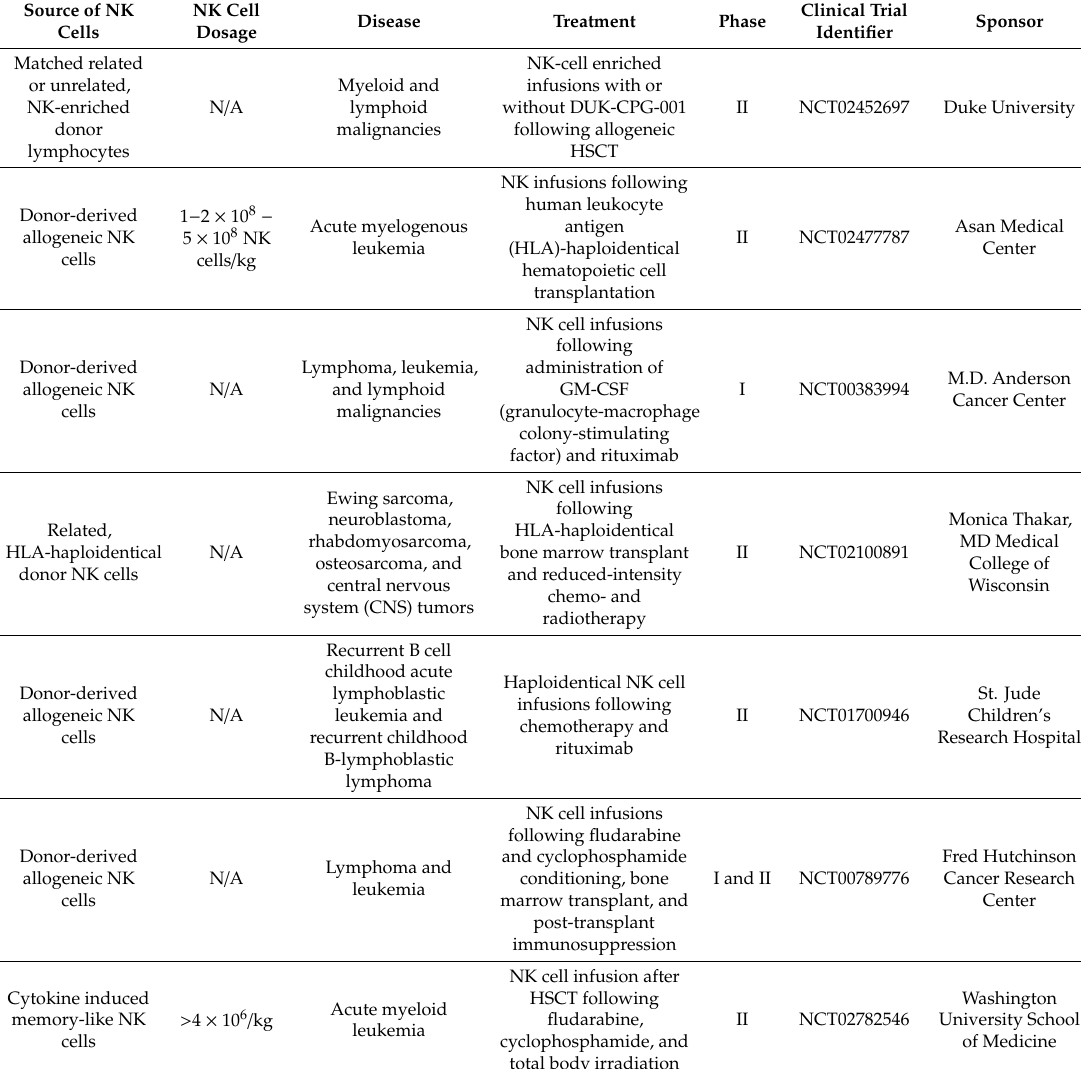
Table 1. Currently active and ongoing clinical trials with allogeneic natural killer (NK) cells within hematopoietic stem cell transplantation